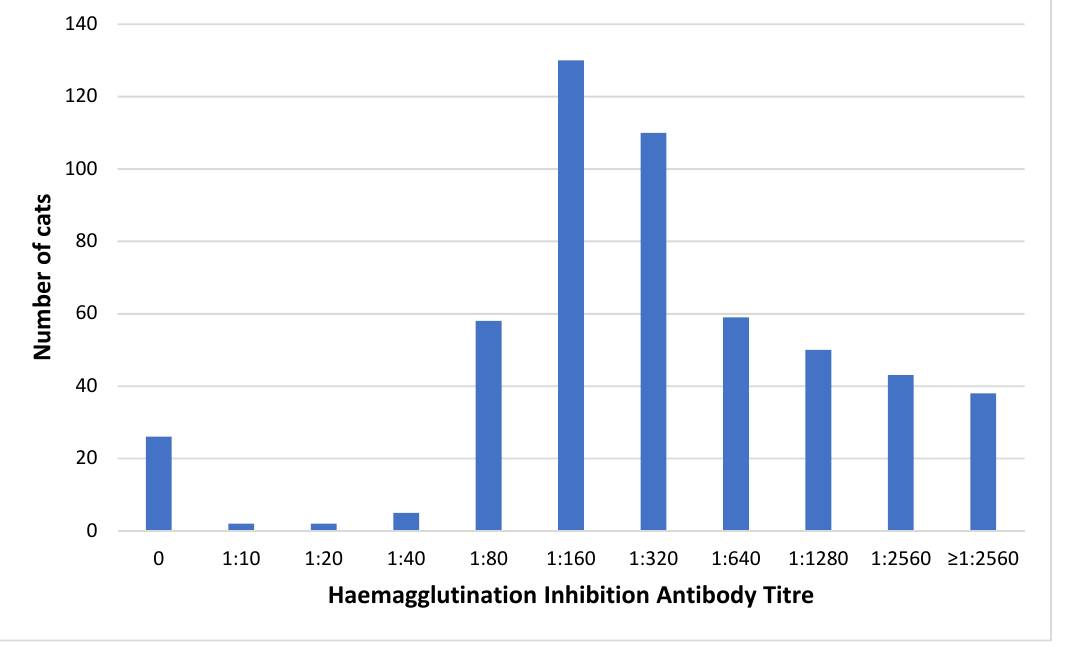
Table 2. Results of logistic regression analysis using model of best fit containing the variables: vaccinated, Sydney (outbreak) location, and